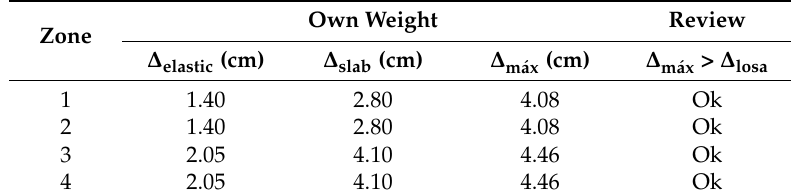
Table 5. Review of permissible displacements by own weight and maximum load.